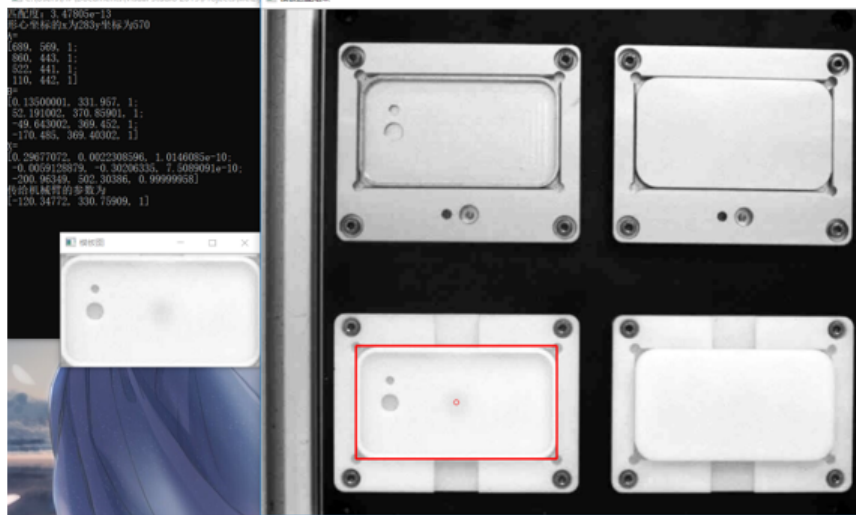
Figure 12. Results for template matching.